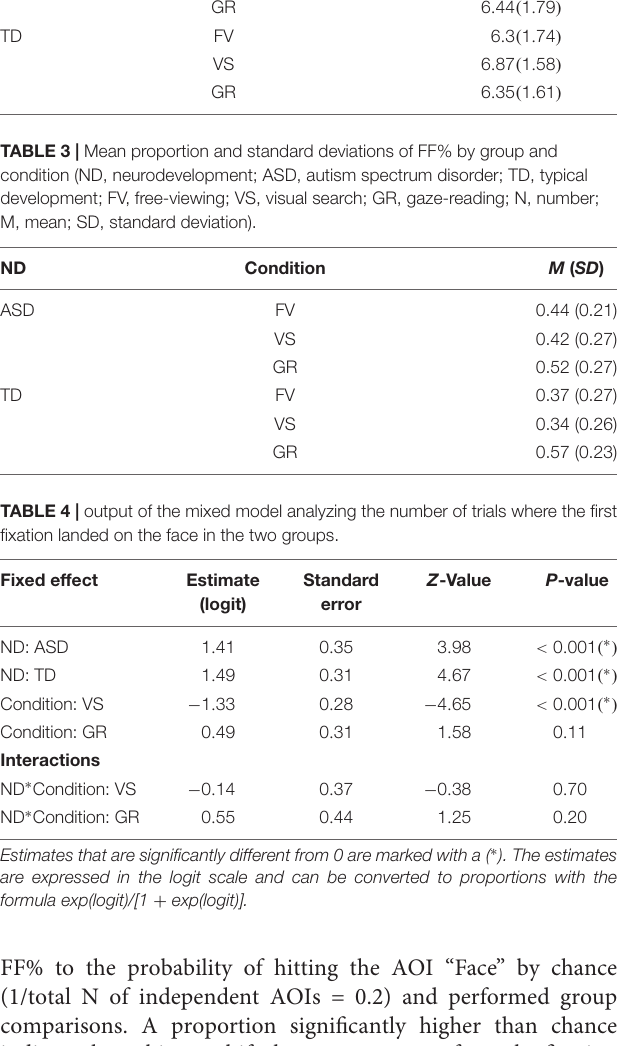
TABLE 6 | Mean LT% on face and standard deviations by group and condition (ND, neurodevelopment; ASD, autism Spectrum disorder; TD,